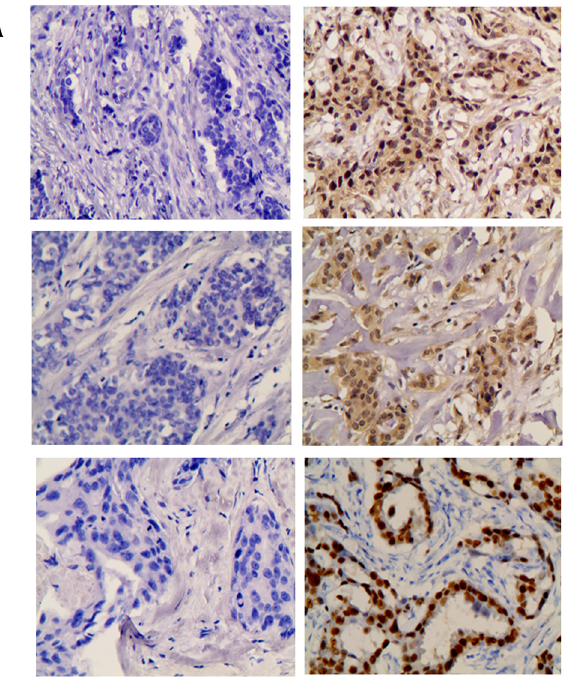
Fig 5. Representative images of immunohistochemical staining for Twist, p-Akt and p-ERK in invasive breast carcinomas. (A) Twist negative expression (left), and Twist positive staining (right). (B) p-Akt negative expression (left), and p-Akt positive staining (right). (C) p-ERK negative expression (left), and p-ERK positive staining (right). Original magnification, 200